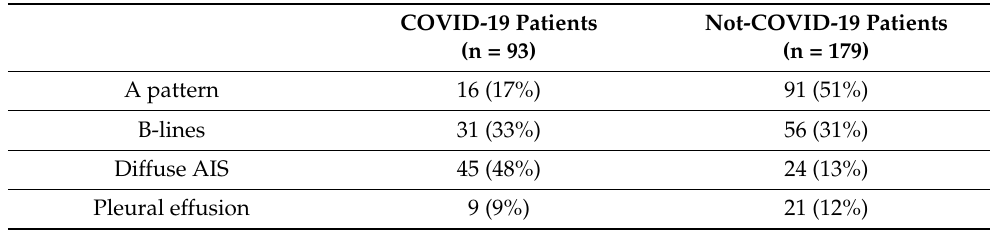
Table 2. LUS findings in COVID-19 and not-COVID-19 patients. AIS, alveolar-interstitial syndrome. B-lines means focal AIS or B-lines without criteria for diffuse